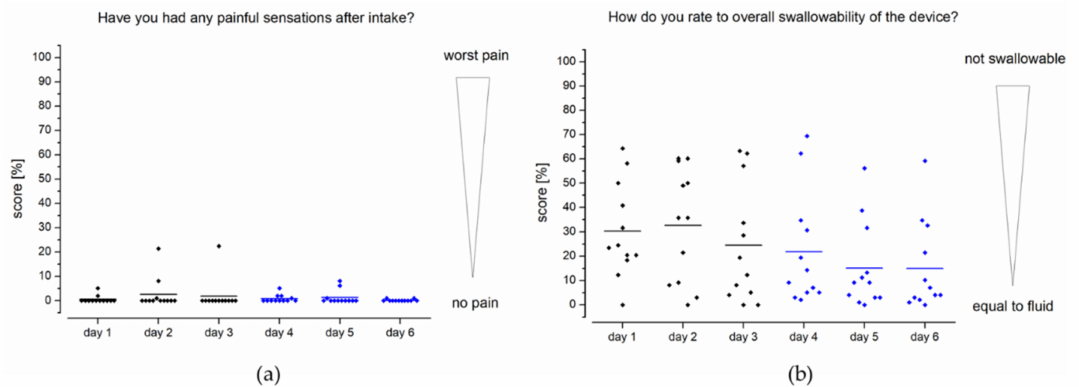
Figure 7. Feedback from healthy volunteers ( n = 12) on painful sensations after intake ( a ) and the device’s overall swallowability ( b ). Study setup A: days 1–3; study setup B: days